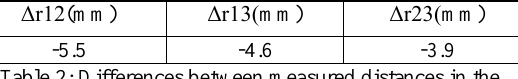
Table 2: Differences between measured distances in the final georefenced image and distances that derived